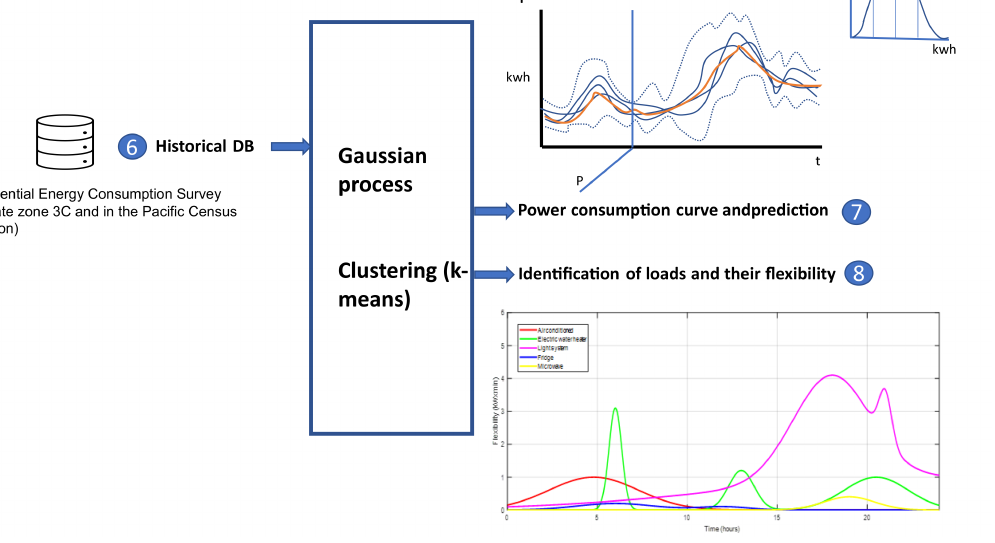
Figure 5. Diagram of Step 2.